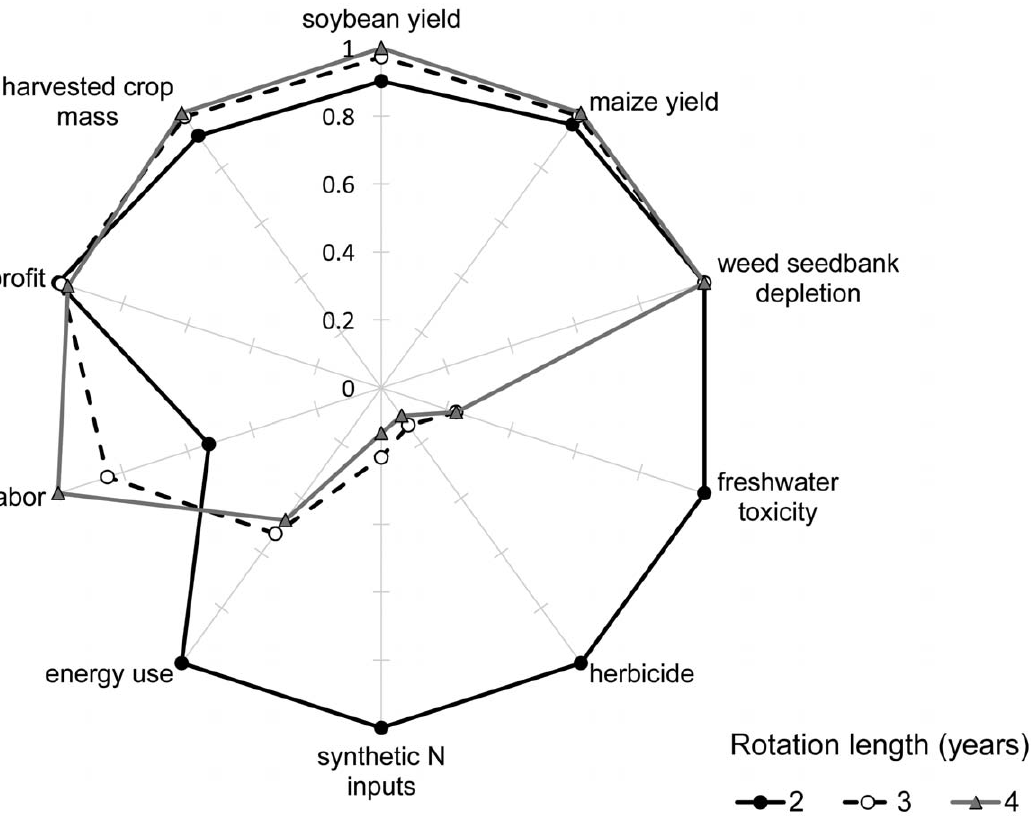
Figure 3. Multiple indicators of cropping system performance. Comparative long-term performance of maize-soybean (2-yr), maize-soybean- small grain/red clover (3-yr), and maize-soybean-small grain/alfalfa-alfalfa (4-yr) cropping systems in Boone, IA, averaged over the 2003–2011 study period. Variable means are normalized on a 0 to 1 scale, with 1 representing the cropping system with the largest absolute value for that variable (N=36 per cropping system). Performance metrics included: maize and soybean yield, rotation-level harvested crop mass, net returns to land and management, manufactured N fertilizer and herbicide application rate, fossil energy use, labor requirements, freshwater toxicity potential and weed seedbank decline (measured as exponential decay constant).